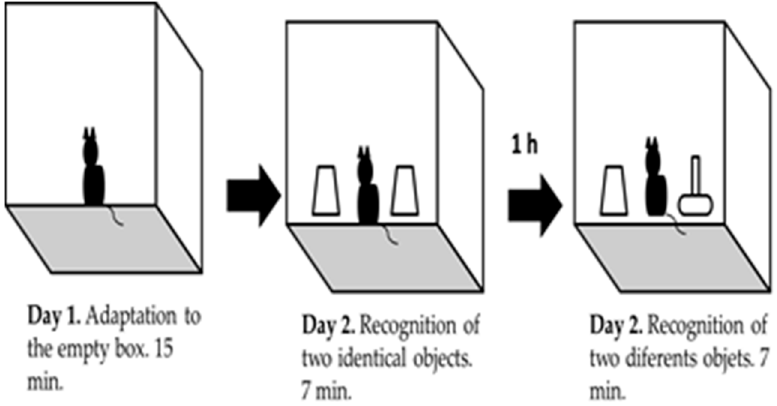
Figure 2. Schematic representation of object recognition task.